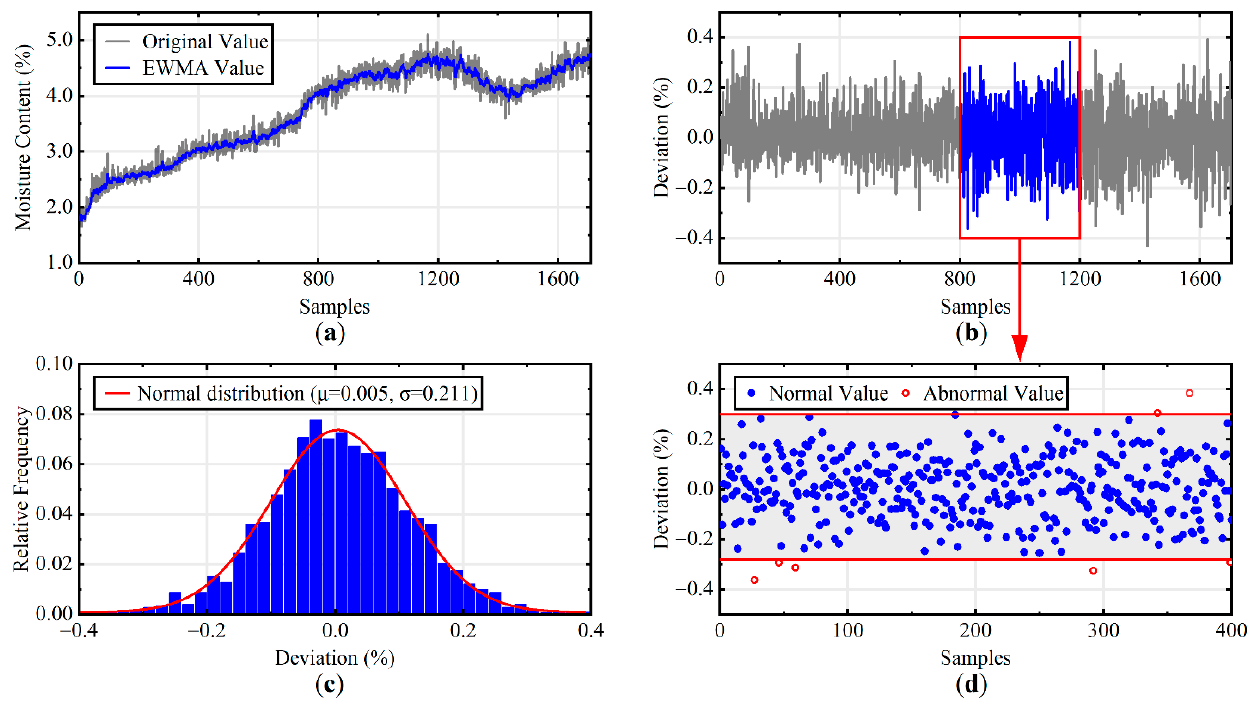
Figure 2. Outlier detection of the moisture content data: ( a ) EWMA value of the moisture content; ( b ) line graph of the deviations; ( c ) distribution of the deviations; ( d ) result of outlier detection.